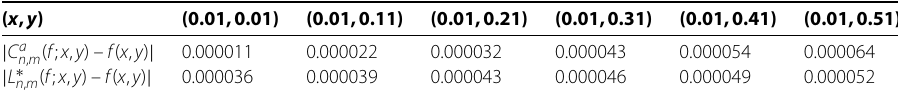
Table 1 Error of approximation for C a n , m and L ∗ n , m